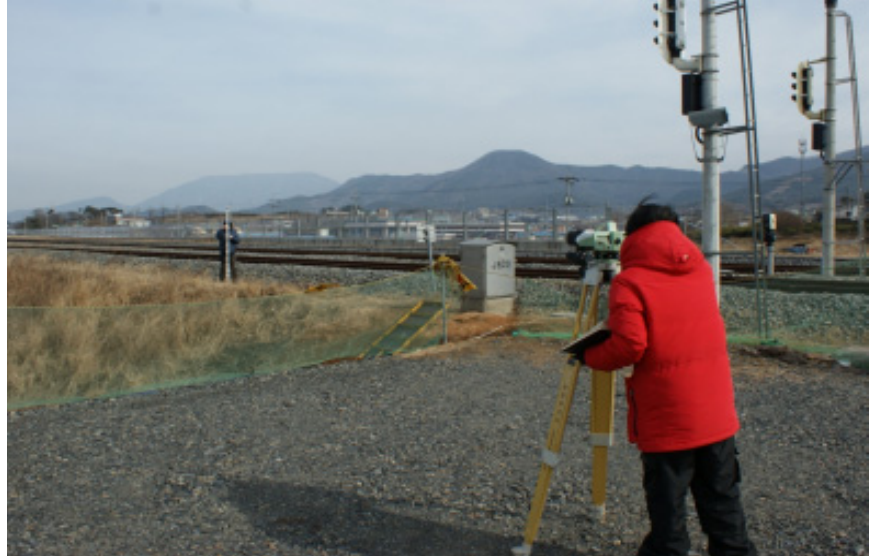
Figure 10. Field measurement of the settlement.